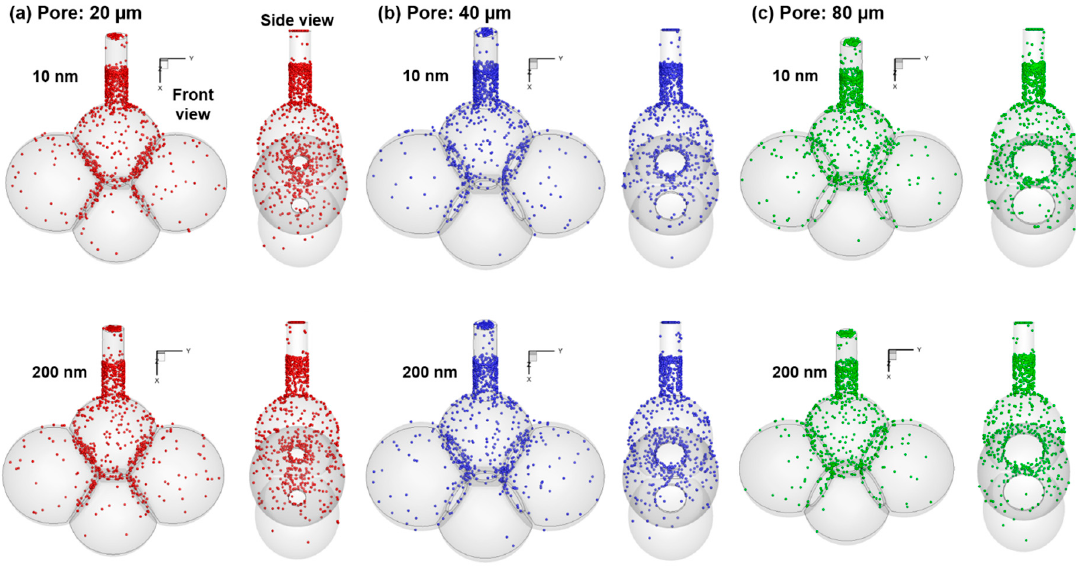
Figure 8. Of surface deposition for 10 nm (upper row) and 200 nm (lower row) particles in the alveolar models with a pore size of ( a ) 20 µm, ( b ) 40 nm, and ( c ) 80 nm.